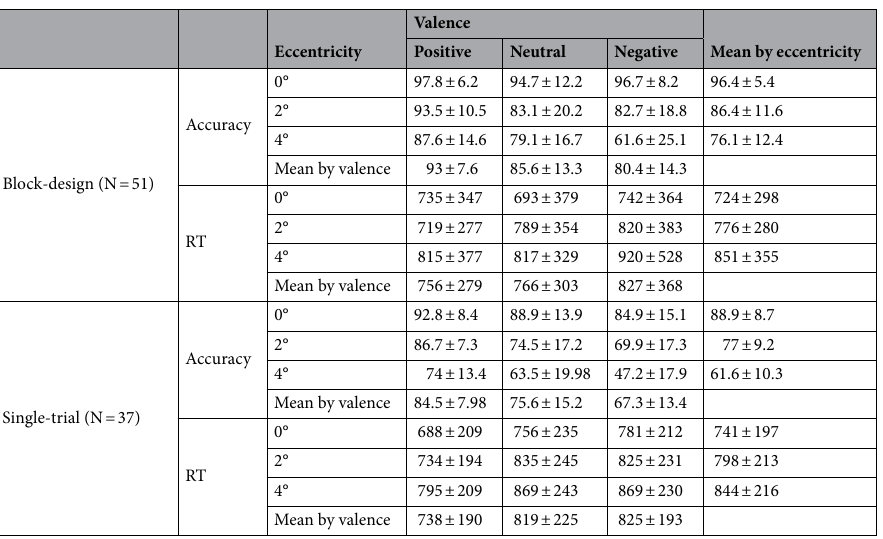
Table 1. Results summary for each experiment according to eccentricity and valence. Accuracy in % correct, RTs in ms. Different valence conditions in different columns, eccentricity presented in different rows. Values are mean ±